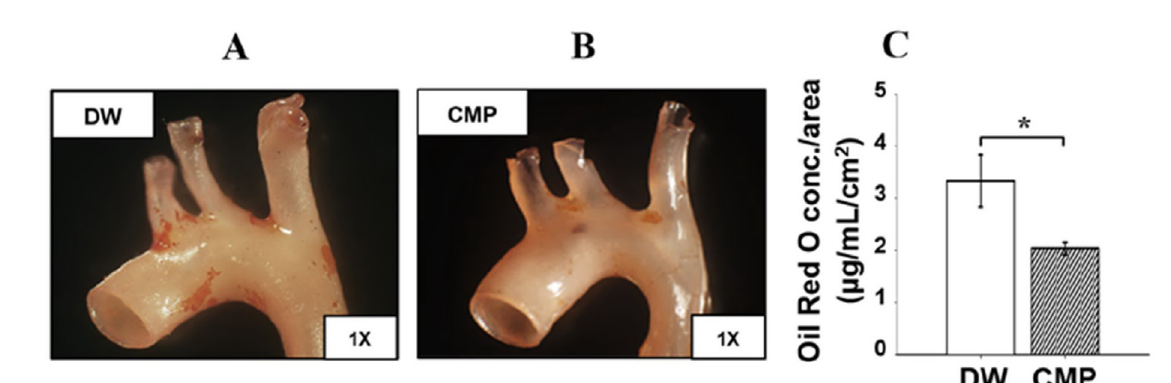
FIGURE 4 - Effects of CMP (1 g/kg) or distilled water (DW) consumption by the middle-aged male rats on aortic arch lipid accumulation. (A) Distilled water (DW), (B) CMP and (C) oil red O concentration. Values represent mean ± SEM of 6 experiments. * Significantly lower than that of the distilled water control group, P < 0.05. SUPPL. TABL E I - Effects of CMP (1 g/kg) or distilled water (DW, control) consumption by middle-aged male rats on fasting plasma glucose and lipid profile.